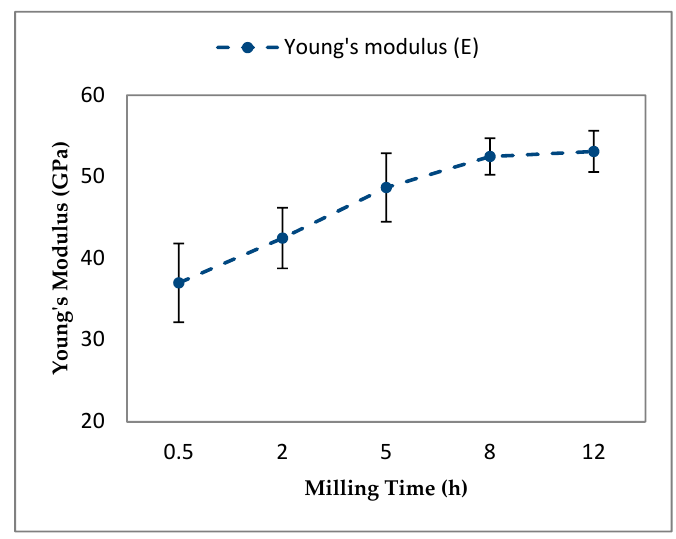
Figure 10. The variation of E values of Al-5Al 2 O 3 nanocomposites as a function of milling time.